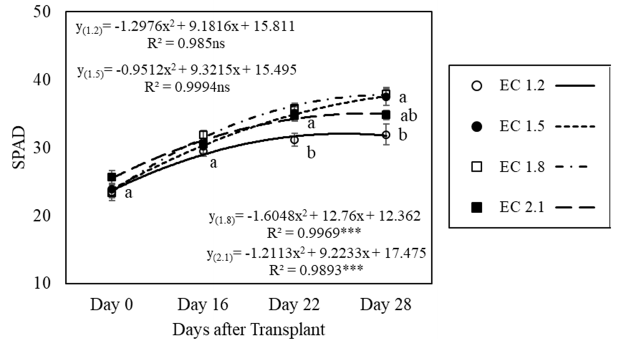
Figure 3. Effect of electrical conductivity (EC) of nutrient solution on relative chlorophyll content (SPAD) value of arugula on the day before transplant, and 16th, 22nd, and 28th days after transplanting into nutrient-film technique hydroponic system containing nutrient solutions with EC 1.2, 1.5, 1.8, or 2.1 dS·m − 1 . Data points with different letters are significantly different according to Tukey’s test ( α = 0.05). Error bars represent the standard errors ( n = 16). ns or *** indicate no signif- icance or significance at P of